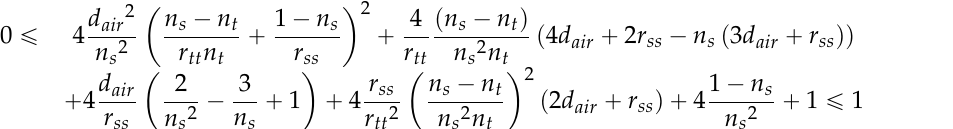
Figure 1. The theoretical values of the Q -factors for a FP cavity formed by straight mirrors, cylindrical mirrors, and spherical mirrors, plotted versus the diffraction length of the cavity.